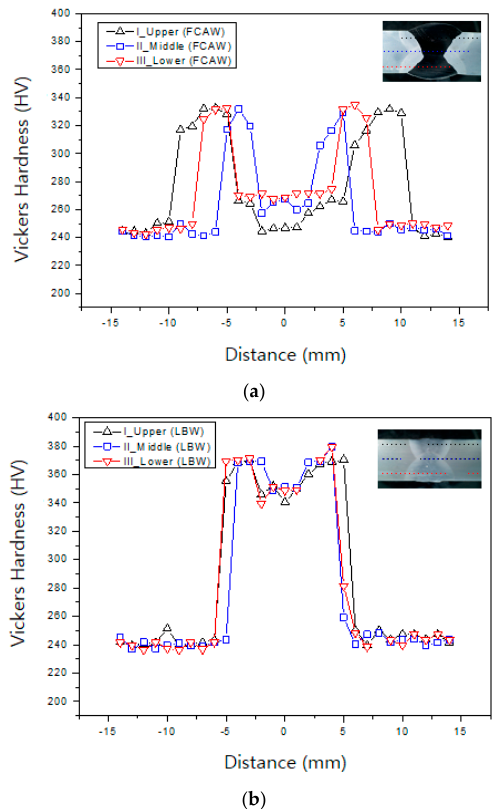
Figure 8. Hardness curve at different upper, middle, and lower positions of FCAW specimen. ( a ) Hardness of FCAW; ( b ) hardness of LBW.